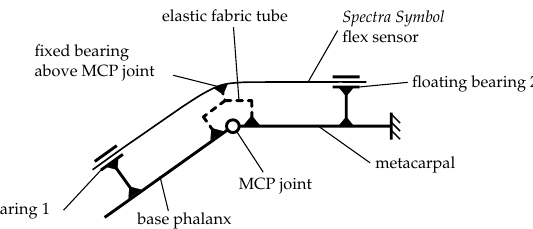
Figure 6. Principle of sensor mounting for the Spectra Symbol ® flex sensor. A mixture of fixed and floating bearings secures a symmetrical bending of the sensor over the joint. Shown for the Metacarpophalangeal (MCP)joint.